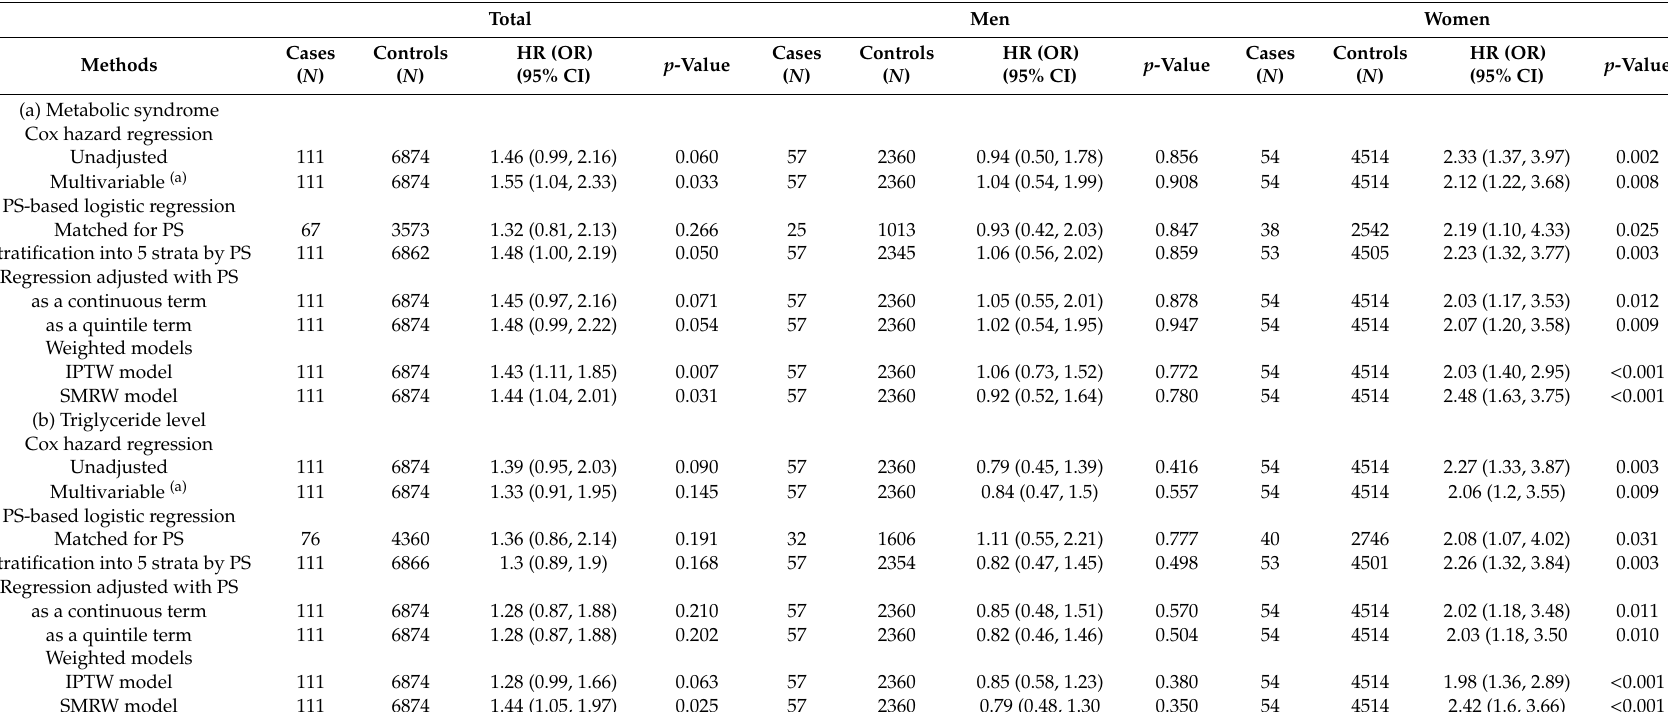
Table 2. Associations between (a) metabolic syndrome, (b) triglyceride level and colorectal cancer risk. Total Men